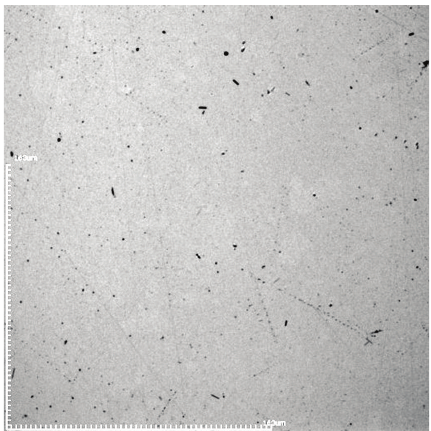
Figure 1: Metallographic image of the original Al-B